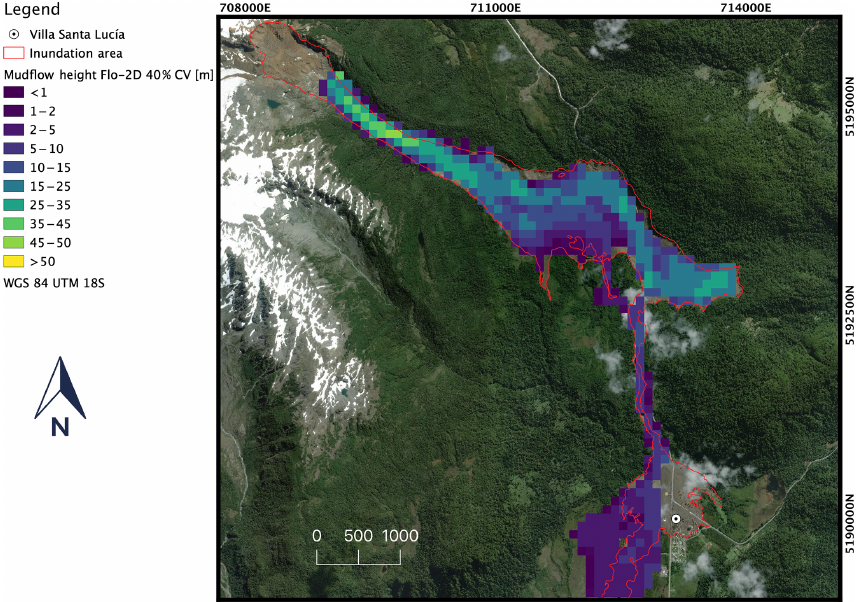
Figure 12. Result for Glenwood 1 using a 40% concentration of water by volume (background ©